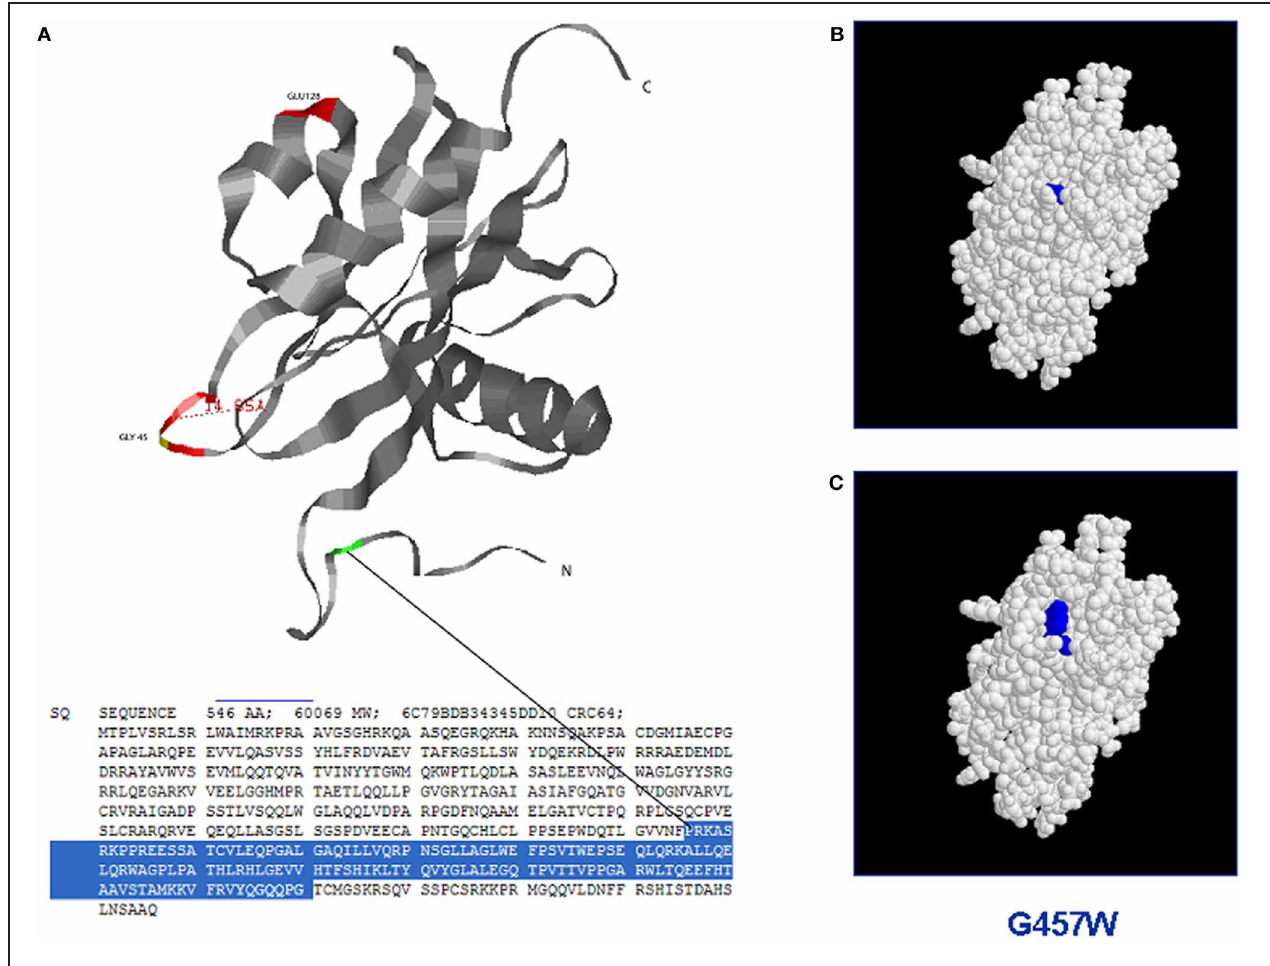
dimensional structure of the NUDIX domain of MUTYH protein ( PDB database ); (B) Protein folding of the wild-type NUDIX domain. (C) Protein switch of the NUDIX domain containing the substitution